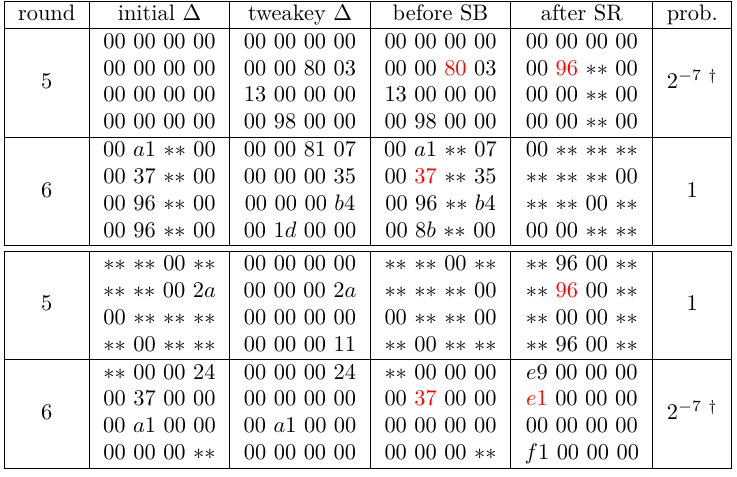
Table 8: Another 2-round differential characteristic of the boomerang distinguisher in Table 7. The probabilities marked with † are only counted once due to the 2-round boomerang